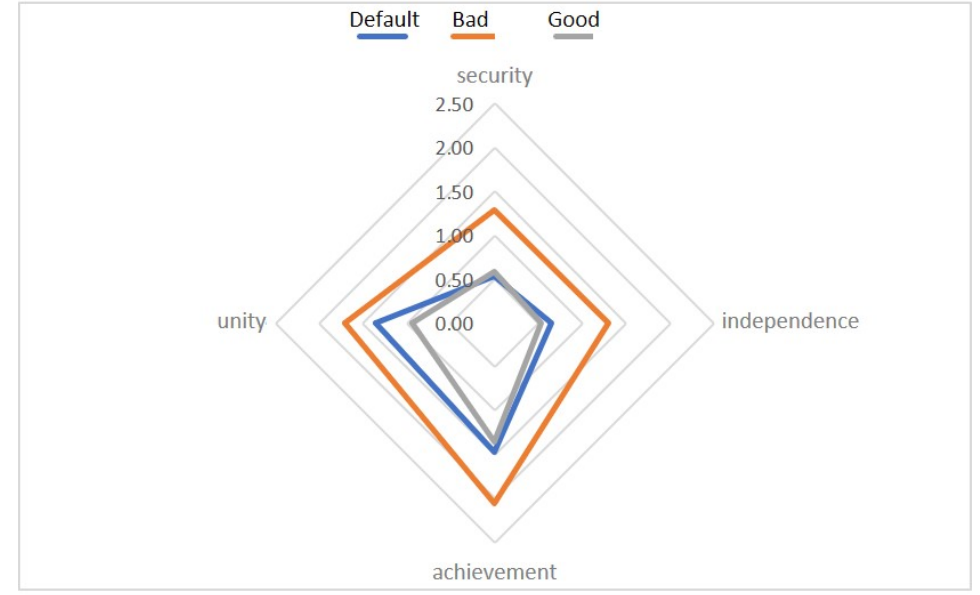
Figure 11. The mean values of the emotional disadaptation level (EDL Test) for the Basic complex, compared by context.